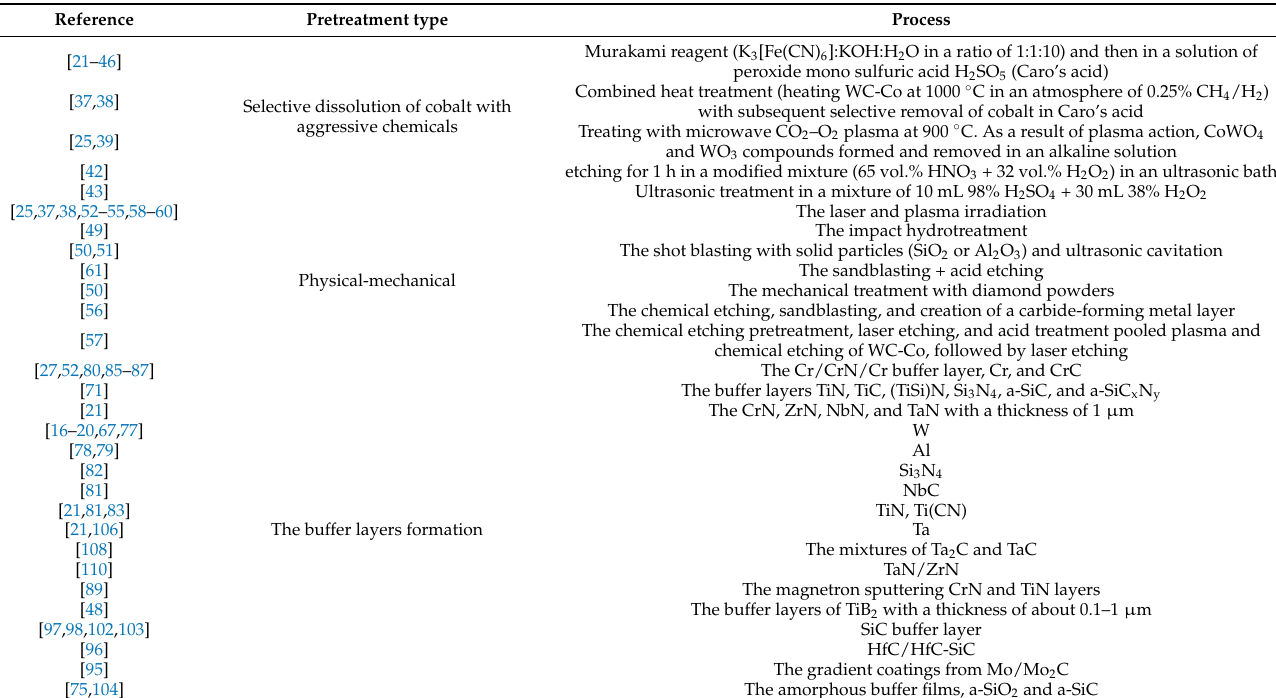
Table 2. Summary of the works on tungsten carbides pretreatment before